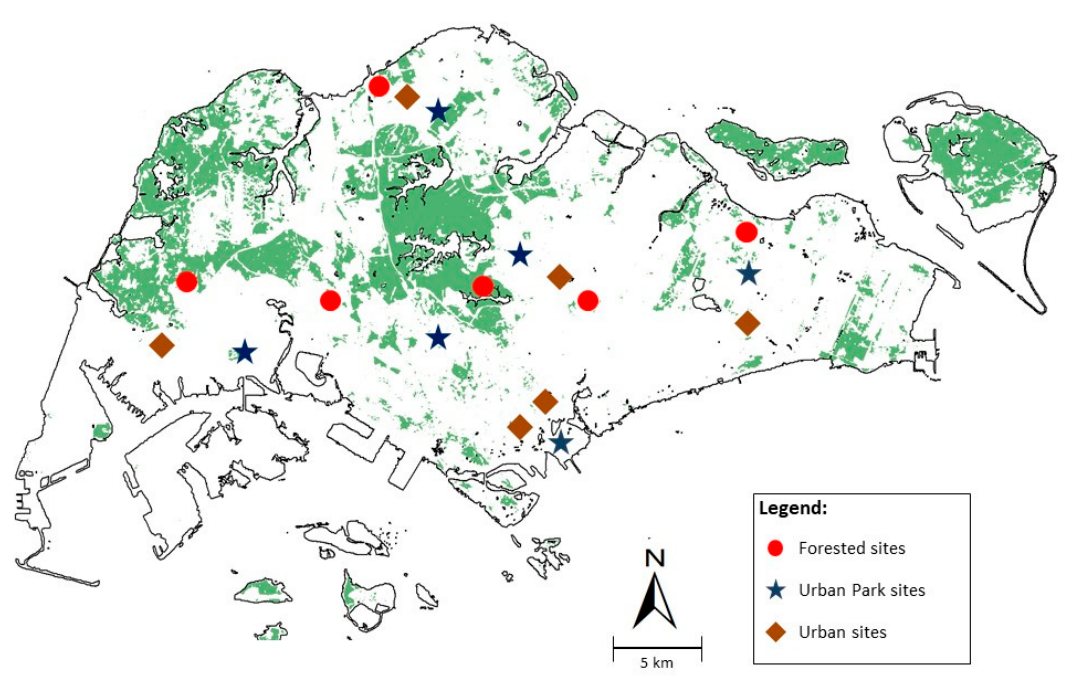
Figure 1. Field survey locations across 6 forest, 6 urban park and 6 urban sites in 2014 spread across Singapore based around sites of high occurrence of L. zampa as recorded on Habitatnews and NSS. One 500 metres transect was established at each site. ( ) are forested survey sites at Admiralty Park forest trail, Bidadari Muslim section, Dairy Farm Pass, Jurong Eco Garden forest trail, Macritchie Nature Trail, and Pasir Ris Mangroves. ( ) are urban park survey sites including Bishan Park, Fort Canning Park, Gardens by the Bay, Jurong Central Park, Mandai-Tekong Park, and Tampines Eco Green. ( ) are urban survey sites including Arcade Mall, Bishan Stadium, Jurong West Stadium, Marina Bay Financial Centre, Raffles Place, Republic Polytechnic, and Tampines Swimming Com- plex.